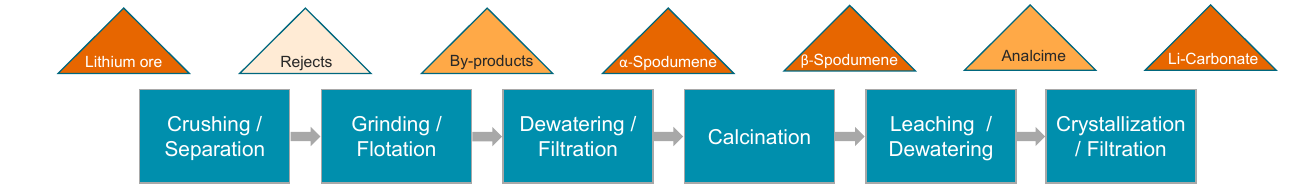
Figure 34. Schematic flow sheet for production of lithium carbonate from hard rock deposits.